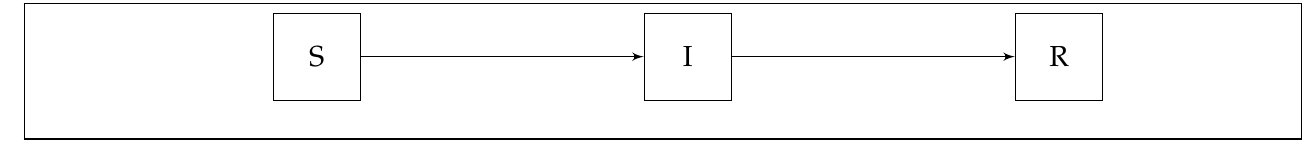
Figure 1. Scheme of the SIR Model